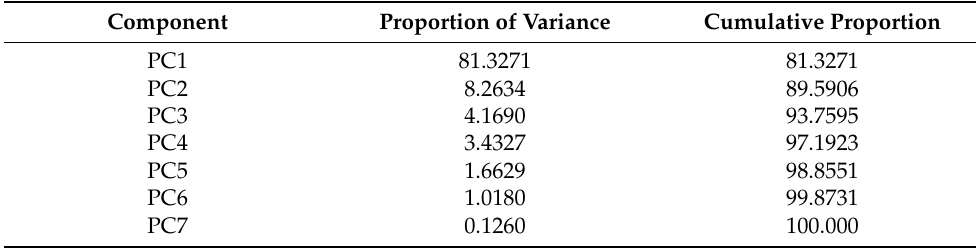
Table 4. Explanatory contribution rates of principal components.